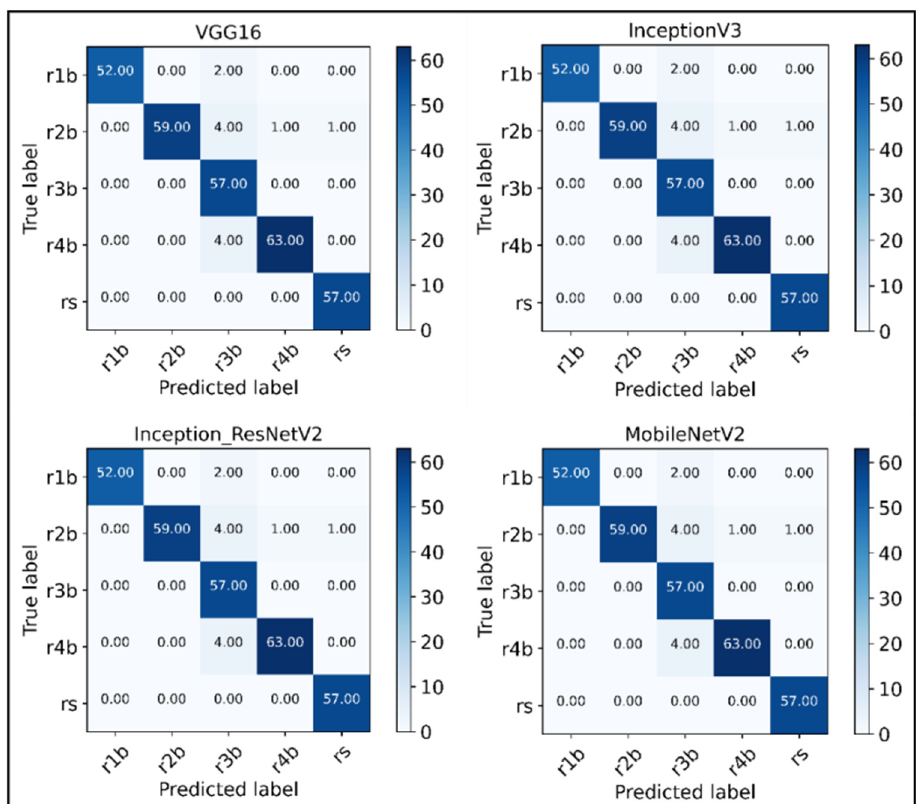
Figure 10. Training and validation graphs of the proposed work with different fine-tuned CNN transfer learning networks ( a ) training accuracy and loss curves ( b ) validation accuracy and loss curves.